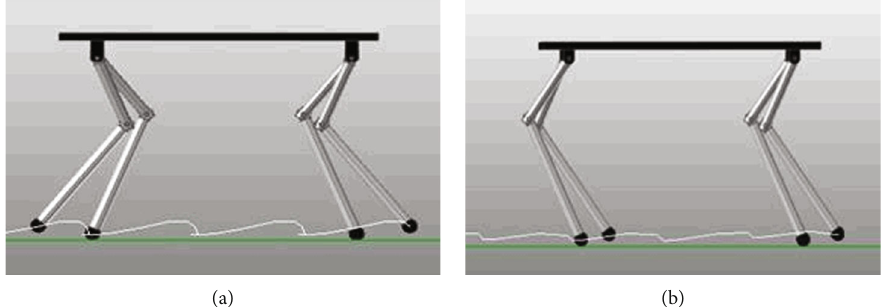
Figure 2: Foot motion track of quadruped robot with (a) elbow joint for front legs and knee joint for back legs and (b) full elbow joint.